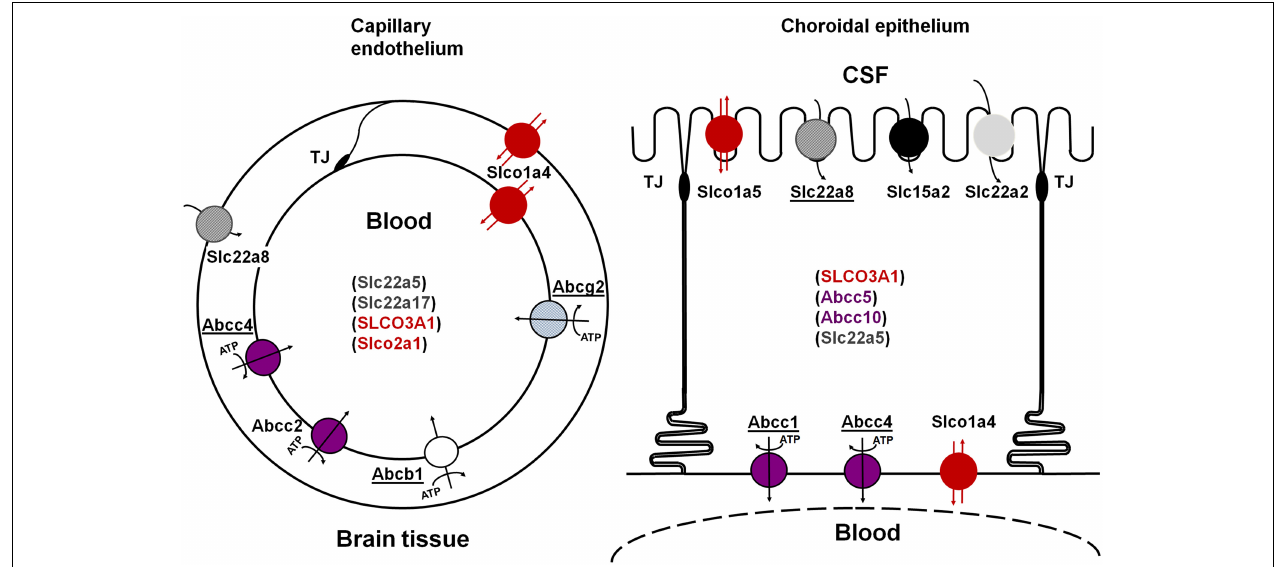
FIGURE 1 | Schematic representation of the main multispecific transporters involved in neuroprotective efflux at the blood-brain (left) and blood-CSF (right) barriers. Underlined names represent transporters for which evidence has also been reported in human. The